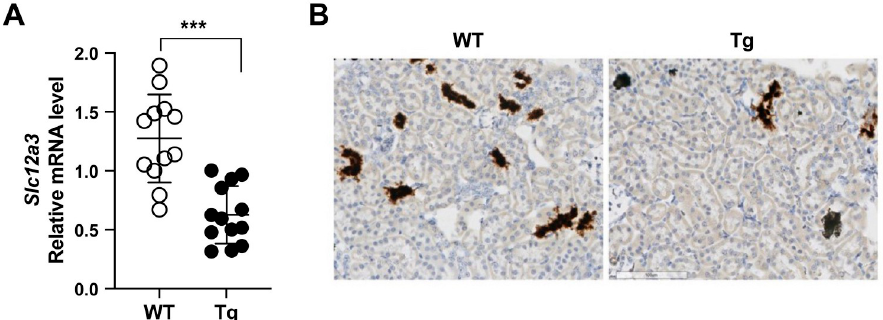
Fig 5. Gene expression of Slc12a3 in the kidney of wild-type (WT) and Vpr transgenic (Tg) mice. ( A ) Renal Slc12a3 gene expression, quantified by qRT-PCR, was significantly lower in Tg mice compared with WT mice. ( B ) Slc12a3 gene expression was markedly lower (fewer cells express Slc12a3 ) in Tg mice compared with WT mice, as determined in situ hybridization, using RNAScope. n = 12–13. ��� P < 0.001, Student’s t test.